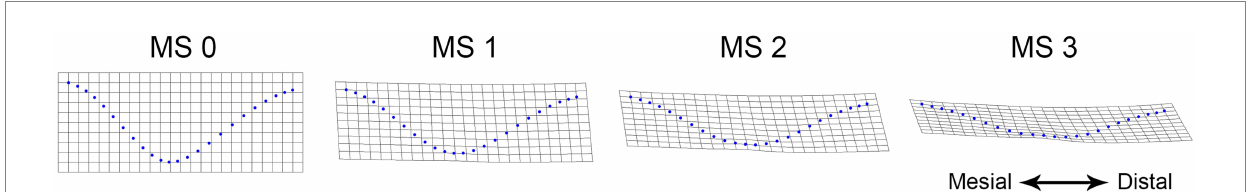
FIGURE 3 Metacone cusp shape deformations obtained from multivariate regression analysis of metacone mesowear score and Procrustes transformed coordinates (Supplementary Table S1; n = 789). Cusp shape deformations at a mesowear score (MS) of 0, 1, 2, and 3.